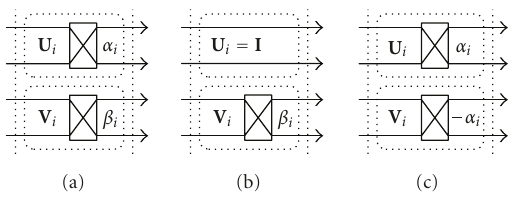
Figure 8: (a) Conventional, (b) simplified, and (c) quaternionic re- alizations of Φ i